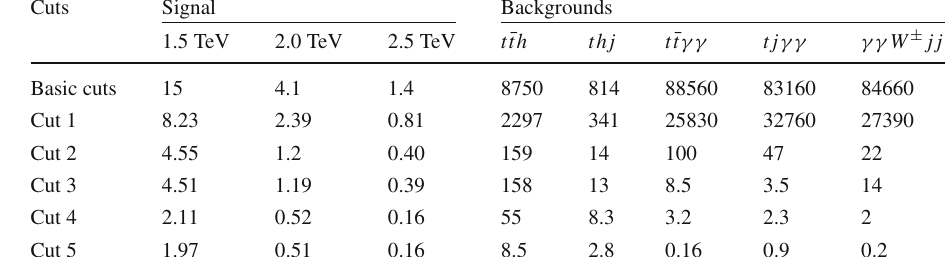
Table 2 The cut flow of the cross sections (in × 10 − 3 fb) for the signals and SM backgrounds at the FCC-hh with κ T = 0 . 1